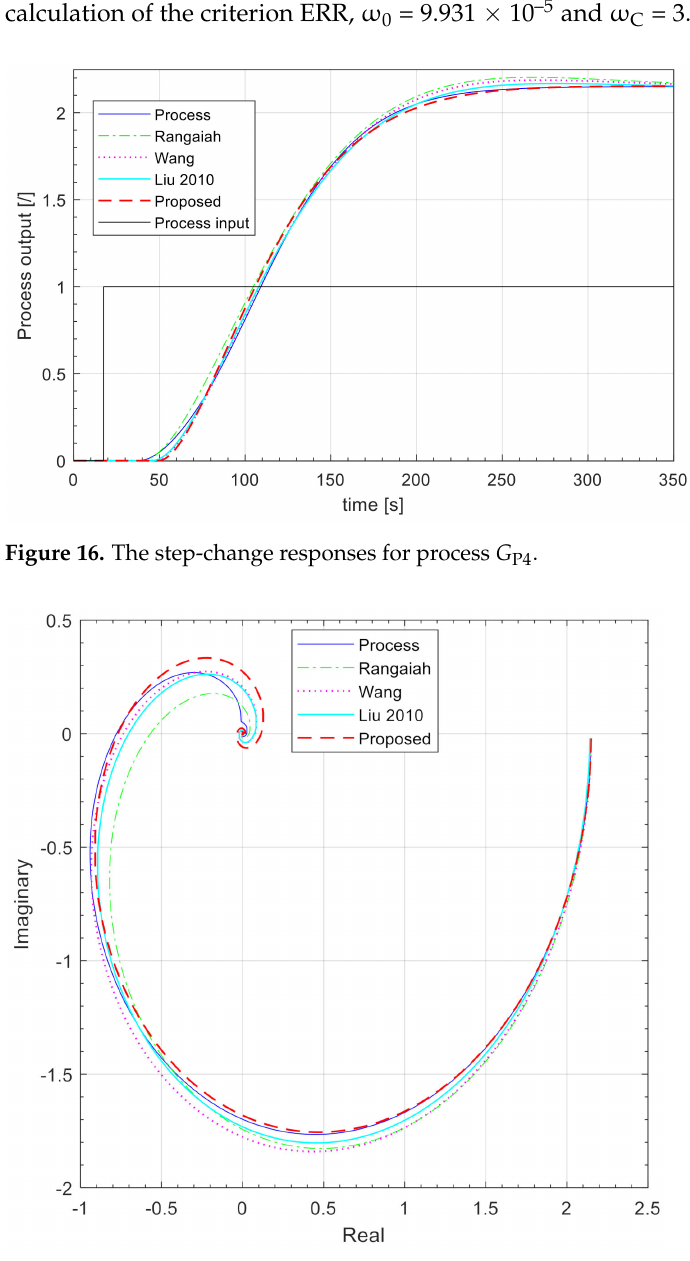
Figure 17. The Nyquist plots for process G P4